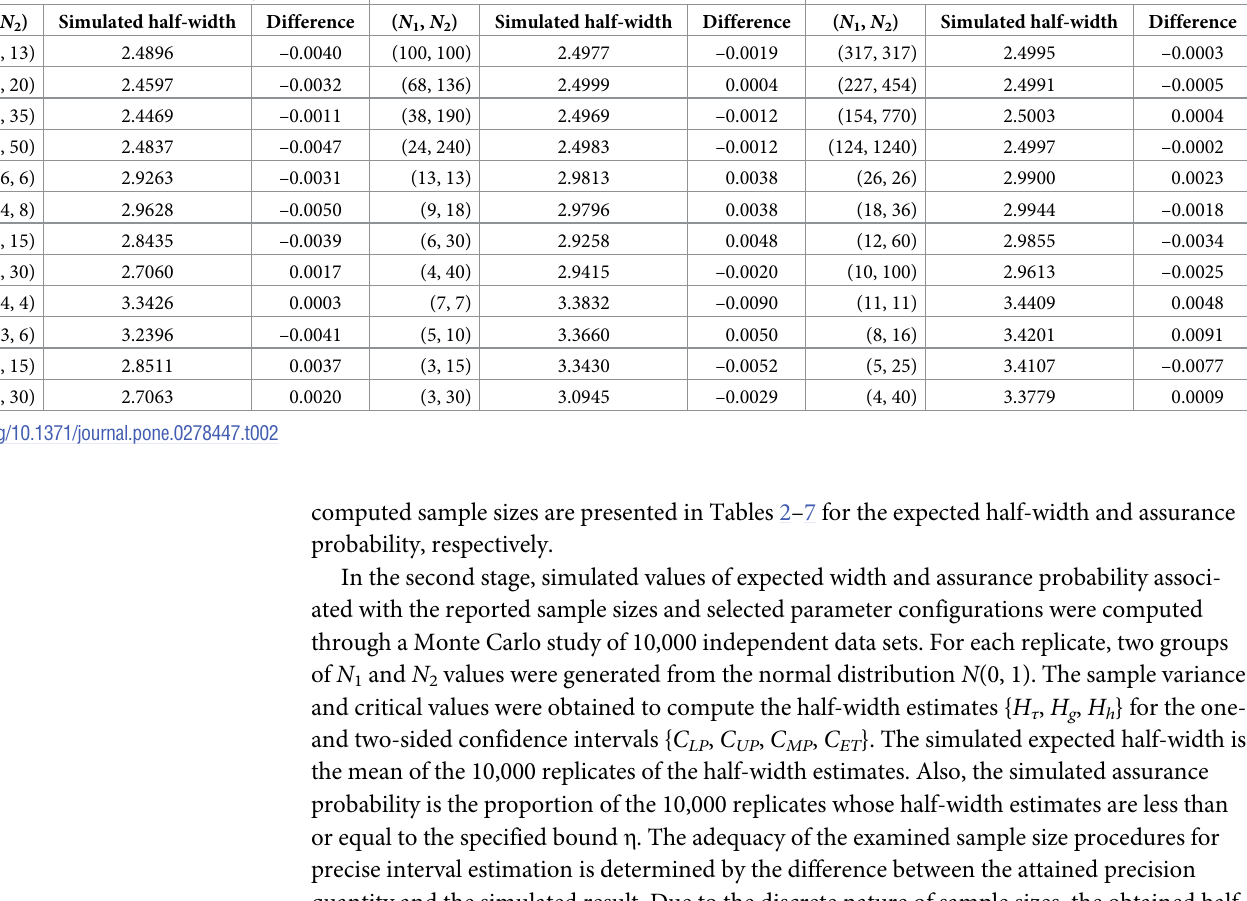
Table 2. The computed sample size, simulated half-width and errors for the 90% reference intervals of the distribution proportion 0.90. One-sided CI C LP and C UP